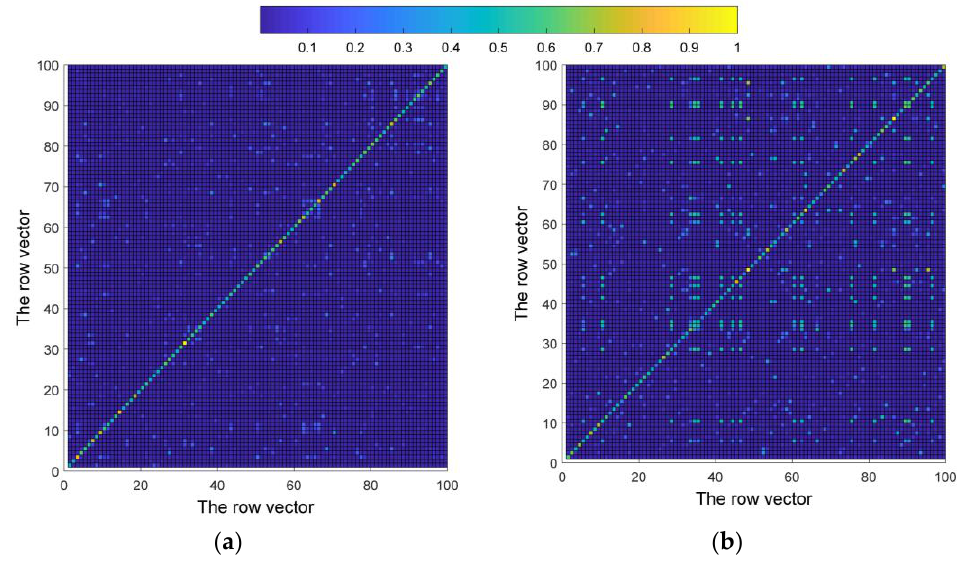
Figure 8. Results of WW T : ( a ) N in = 100; ( b ) N in = 200.